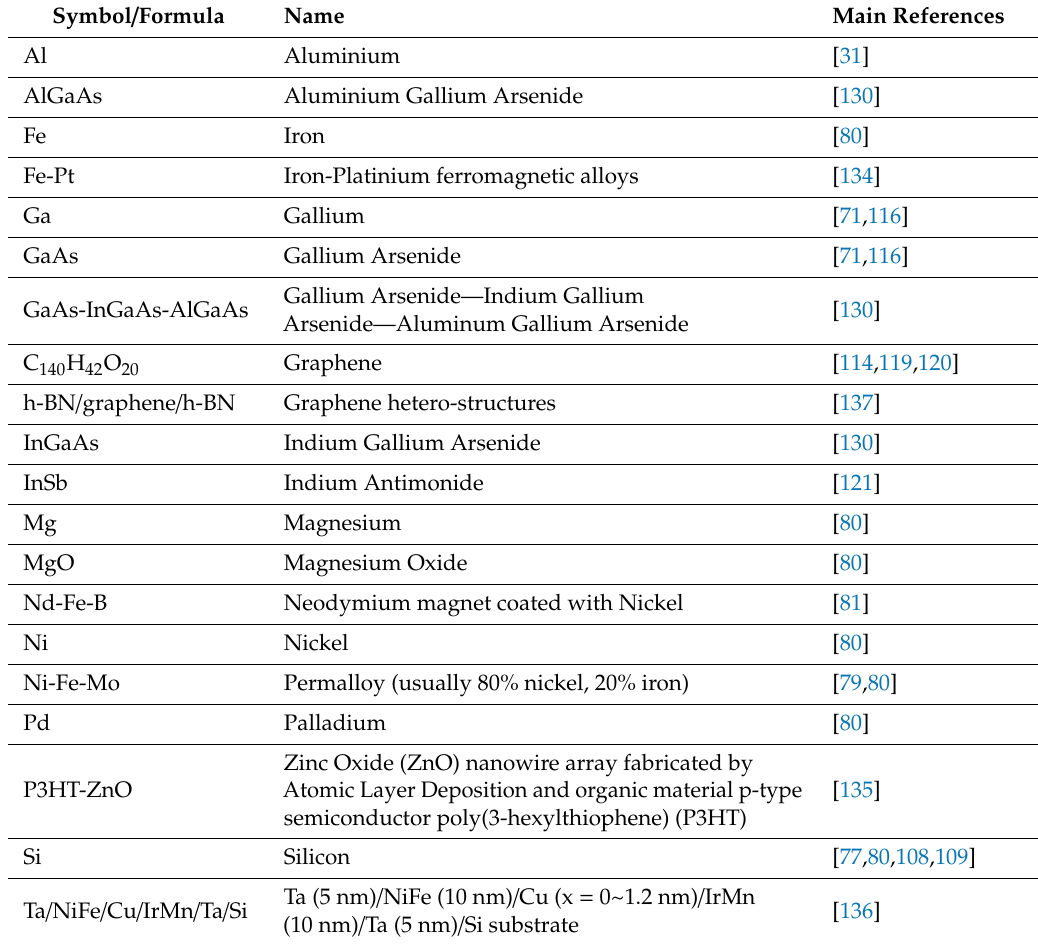
Table 4. Summary table of materials and elements used for Hall E ff ect studies across the